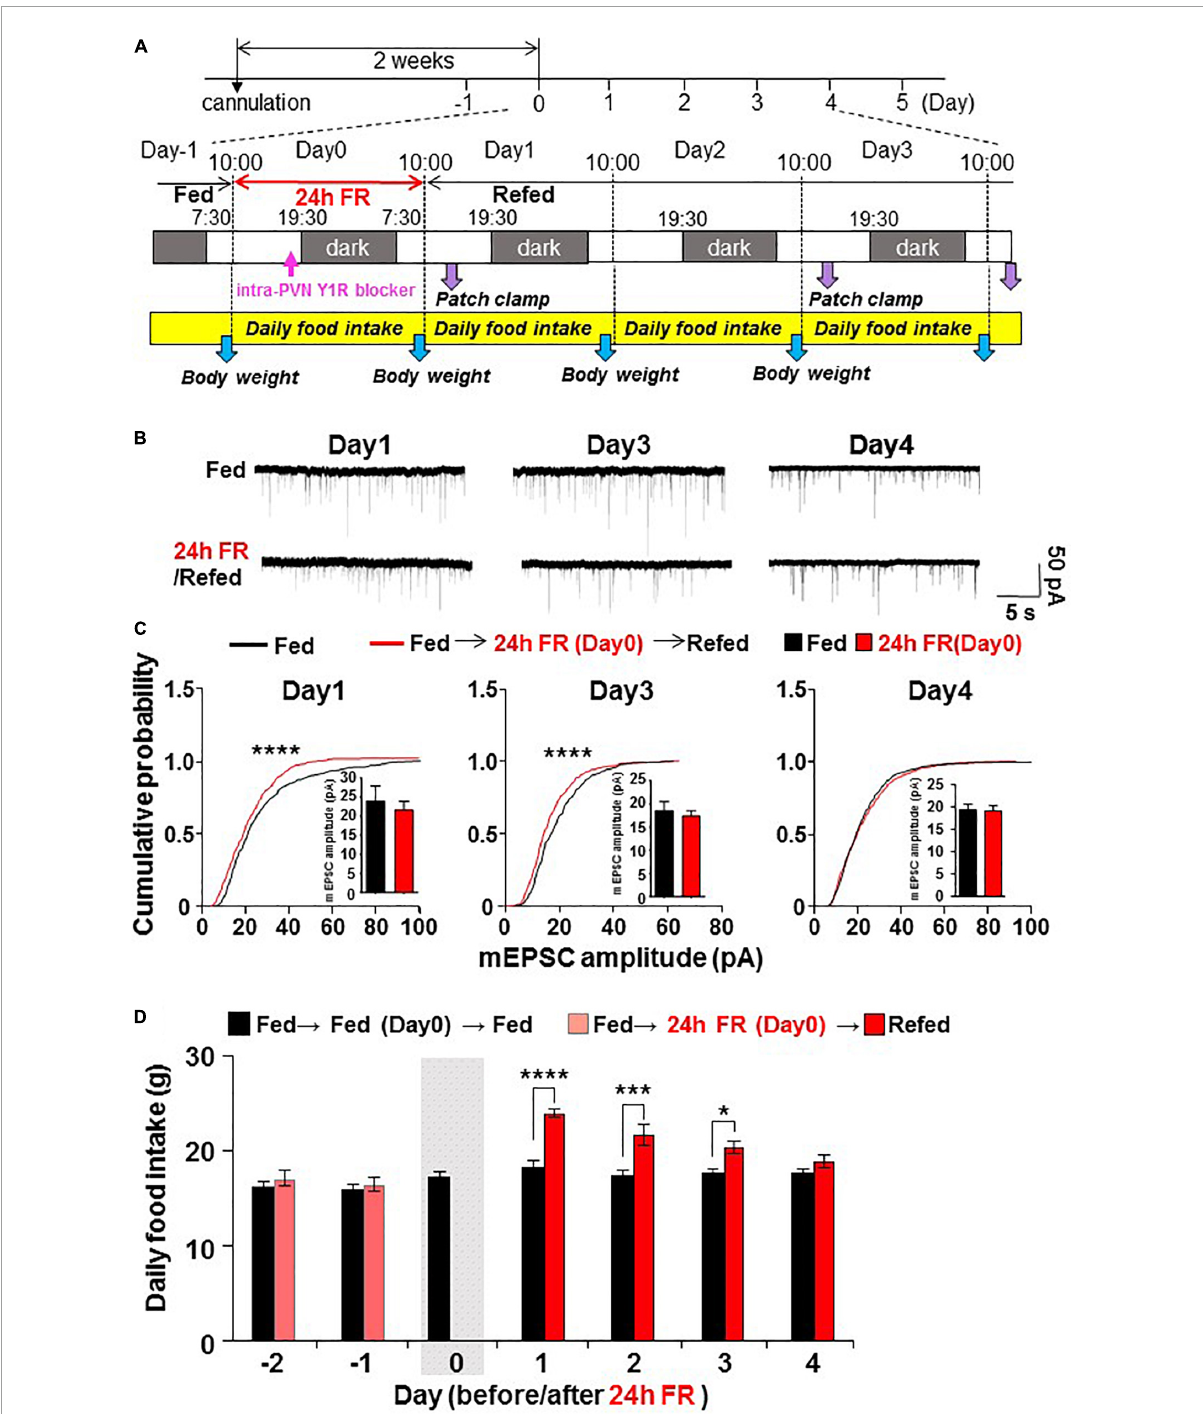
FIGURE1 Twenty four hours food restriction (24 h FR) depresses synaptic currents on paraventricular nucleus (PVN) oxytocin (OXT) neurons and leads to hyperphagia on refeeding. (A) Protocol of the in vivo and ex vivo experiments. OXT mRFP rats were fasted for 24 h from 10:00 on Day 0 to 10:00 on Day 1. In Figures 5A–C , the Y1R antagonist was injected intra-PVN at 19:00 also on Day 0. Subsequently, hypothalamic slices were prepared and PVN OXT neurons were subjected to whole-cell patch-clamp recording on Days 1, 3, and 4 of re-feeding. Daily food intake (10:00–10:00 next day) and body weight were measured. (B , C) 24 h FR depressed mEPSC (B) and cumulative probability distribution of mEPSC amplitudes (C) in PVN OXT neurons on Days 1 and 3 but not Day 4 of re-feeding. **** P < 0.0001 by Kolmogorov–Smirnov test. n = 9 in each group. (D) ,